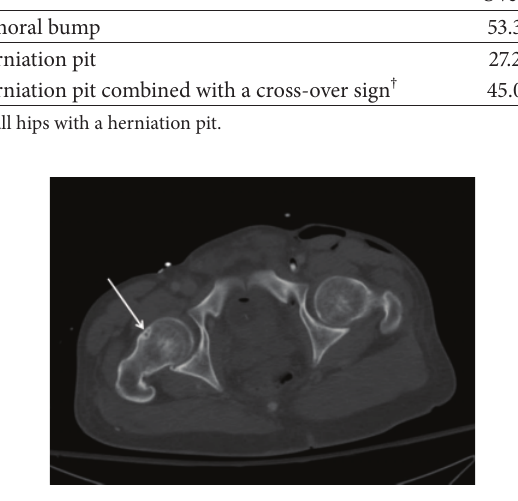
Figure 3: A herniation pit can be seen at the anterosuperior right femoral neck (arrow). It is radiolucencies areas surrounded by a sclerotic margin.